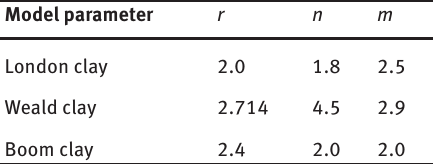
Table 4: CASM parameters for different clays.